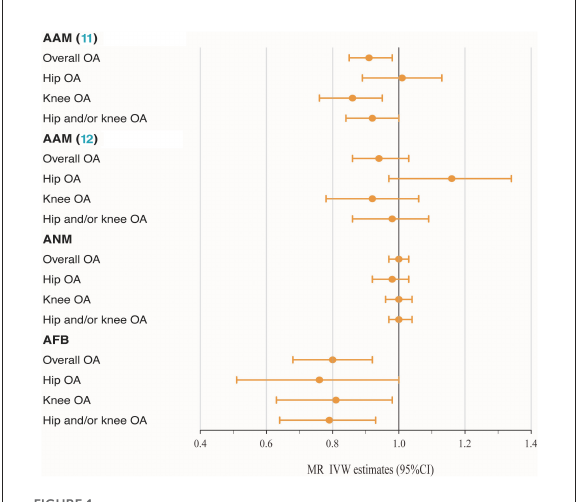
FIGURE1 Forest plot of hormonal reproductive factors on the risk of OA and subtypes in IVW estimates.